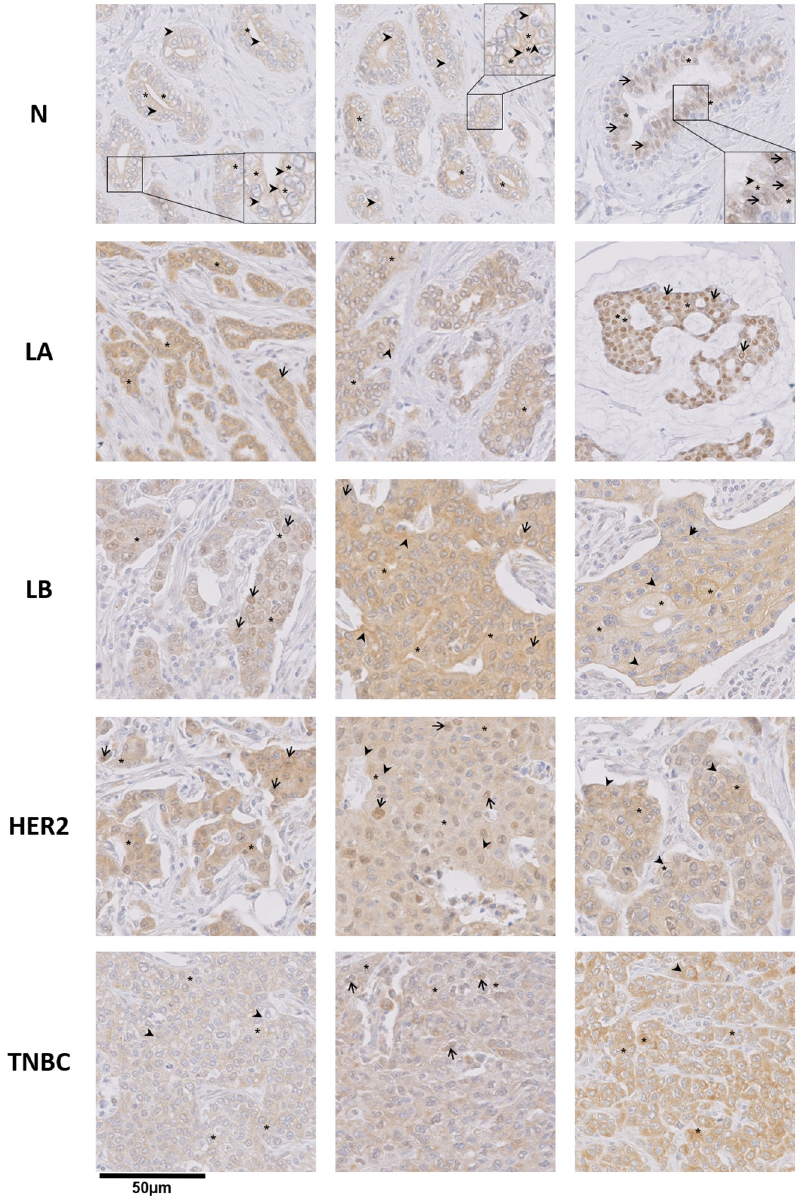
Figure 5. MEP50 is more expressed in breast cancer subgroups compared to normal breast tissues. The expression and localization of MEP50 protein were analyzed by IHC in the Curie cohort. Three representative images of MEP50 staining are shown for the different breast cancer subgroups and normal breast tissue to illustrate its heterogeneous expression and distribution (scale bar = 50 µm). To better visualize cytoplasmic MEP50 and plasma membrane-associated MEP50 in normal samples, a part of the image is shown with a higher magnification (2 × ) in the inset. Arrows, arrowheads, and asterisks indicate MEP50 staining in the nucleus, plasma membrane, and cytoplasm, respectively. Altogether, our study highlights the differential subcellular localization of MEP50 between cancerous and normal breast tissues. Importantly, its subcellular distribution is highly heterogenous within the cancer tissues as well as normal breast